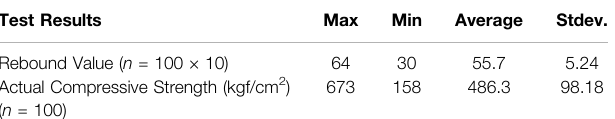
TABLE 1 | Rebound hammer and core sample test results summary. Test